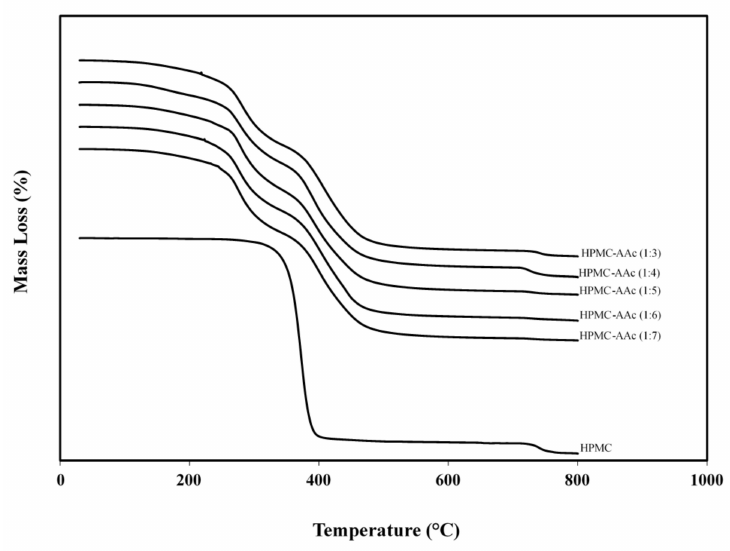
Figure 7. Thermogravimetric analysis of HPMC-AAc matrices (1:7, 1:6, 1:5, 1:4, 1:3) and HPMC powder; scan rate 20 ◦ C min − 1